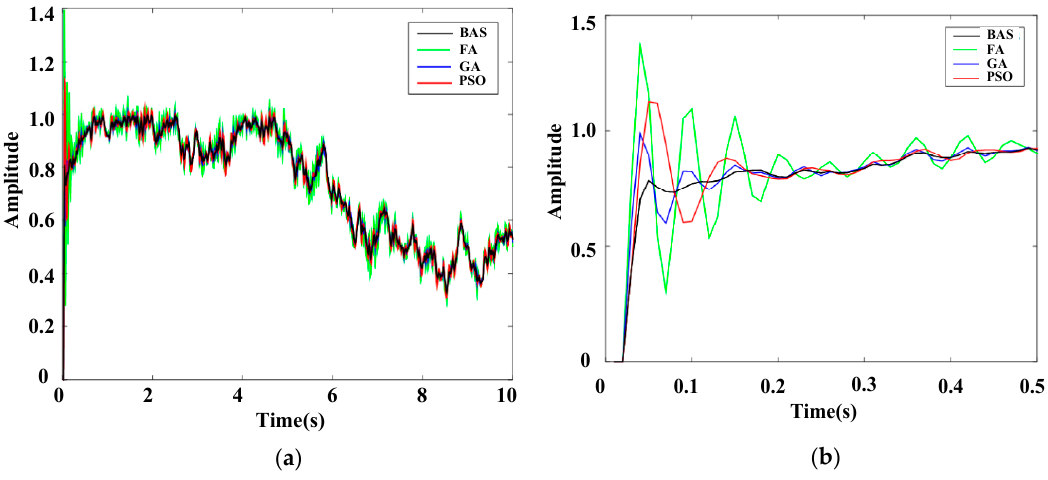
Figure 15. Response curves of the random signal l. ( a ) Whole response curves. ( b ) Local amplification curves.